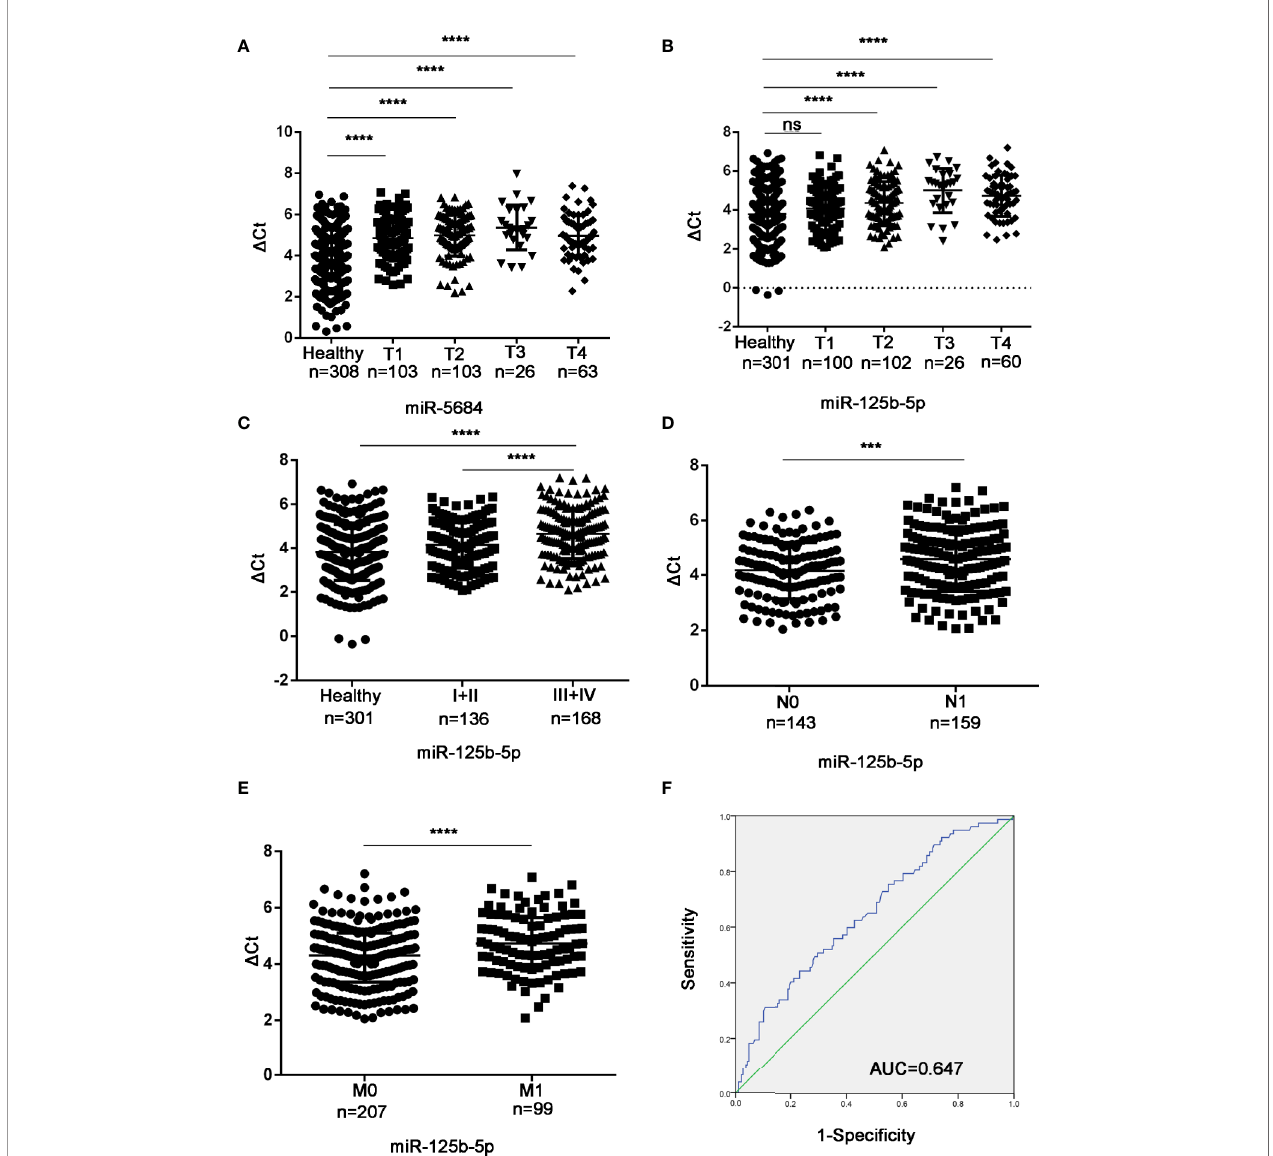
FIGURE 8 | Association between the serum exosomal miRNAs and tumor stage. Expression levels of (A) miR-5684 and (B) miR-125b-5p in T and N stages patients. (C) Serum exosomal miR-125b-5p expression in early stage (I+II) and advanced stage (III+IV) patients. (D, E) Statistical association between miR-125b-5p and (D) lymph node metastasis and (E) distant metastasis. (F) The AUC of serum exosomal miR-125b-5p was 0.647 in metastatic patients relative to non-metastatic NSCLC patients. (***P < 0.001, ****P < 0.0001, ns, not signi fi